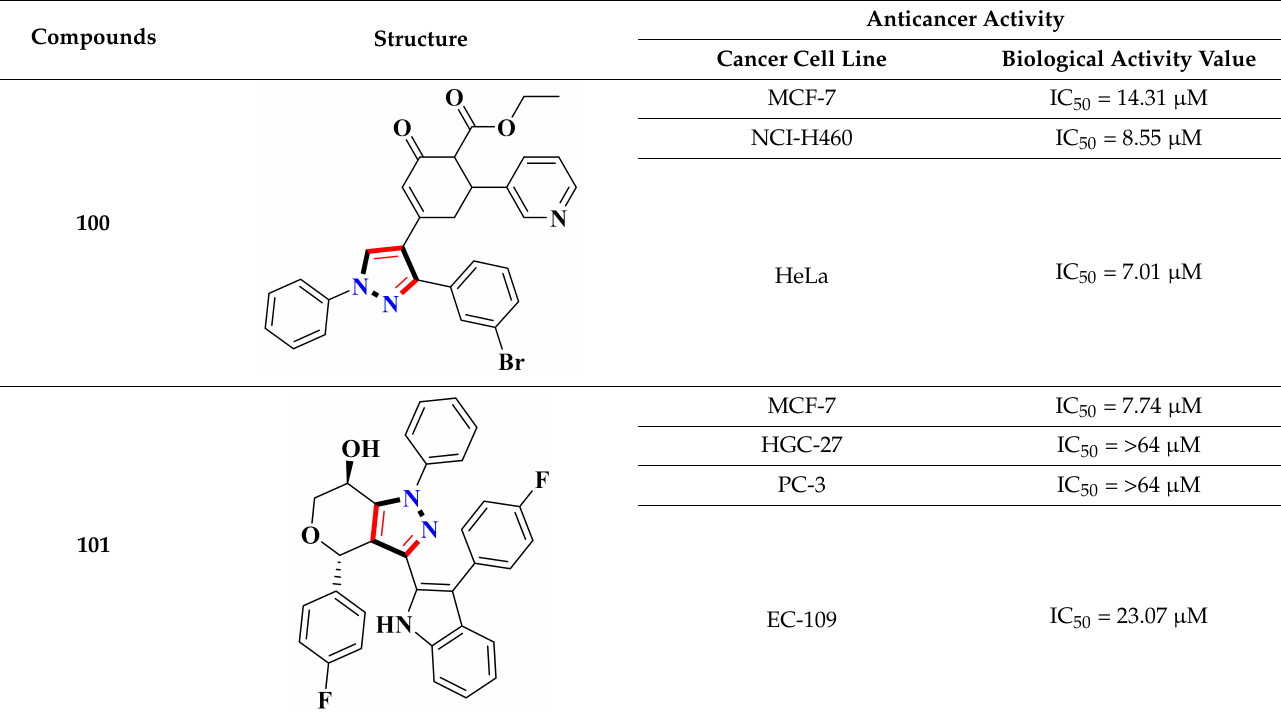
Table 8. Representative compound structures 100 to 112 and their anticancer